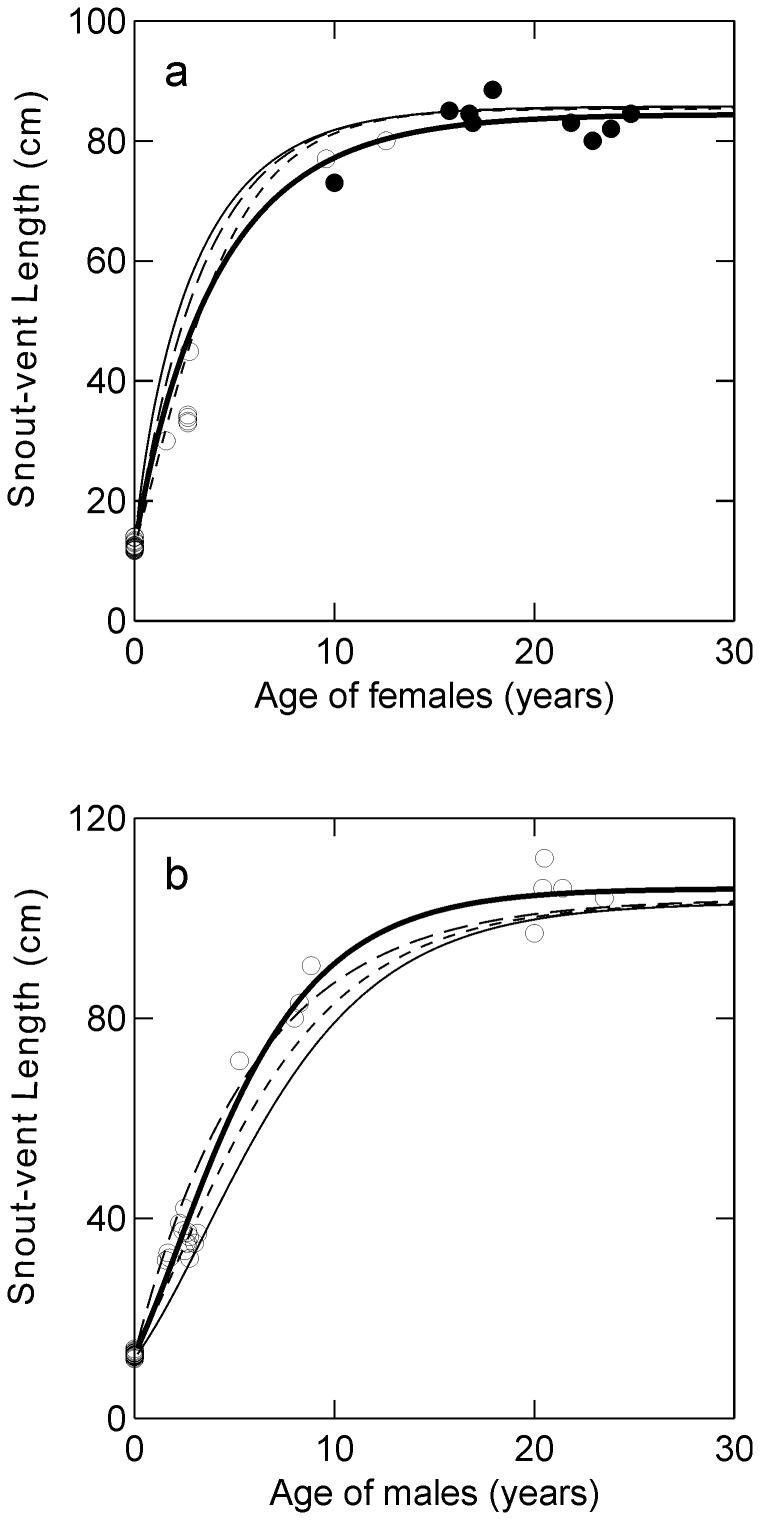
Relationship between size and age for known-age female (a) and male (b) Caiman crocodilus yacare (circles) based on the Richards curve (thick continuous line).Filled circles indicate females that were captured attending nests. Models based on growth-rate-on-size relationships for animals of unknown age are given by the fine continuous line (full Richards model), short dashes (von Bertalanffy, m = 0.667) and long dashes (monomolecular, m = 0).